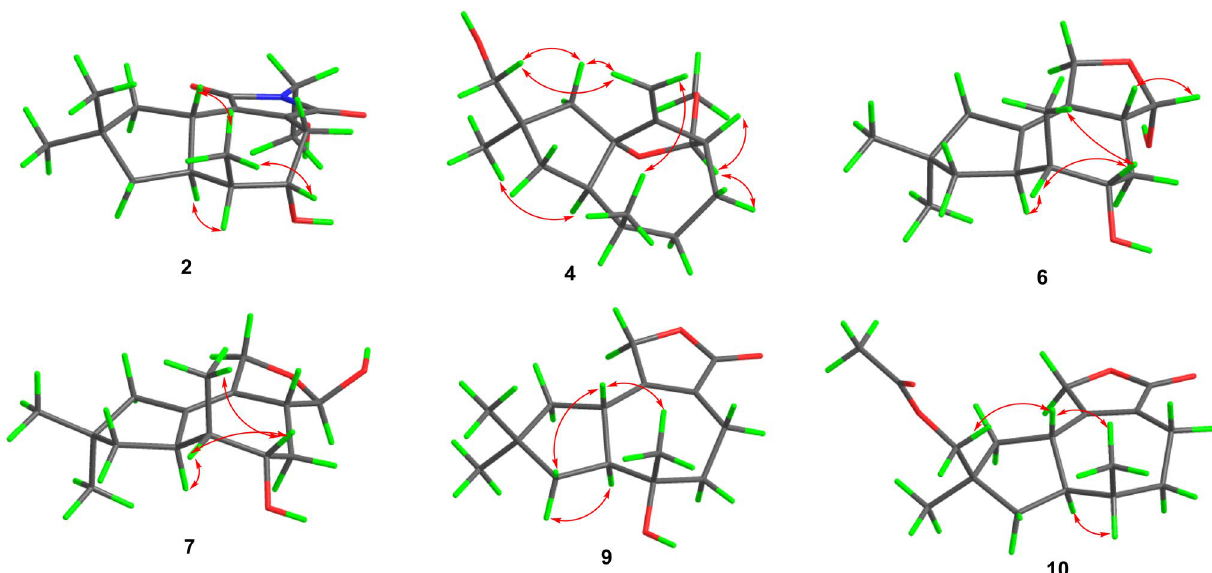
Fig. 4 Key ROESY correlations of compounds 2 , 4 , 6 / 7 , 9 , and